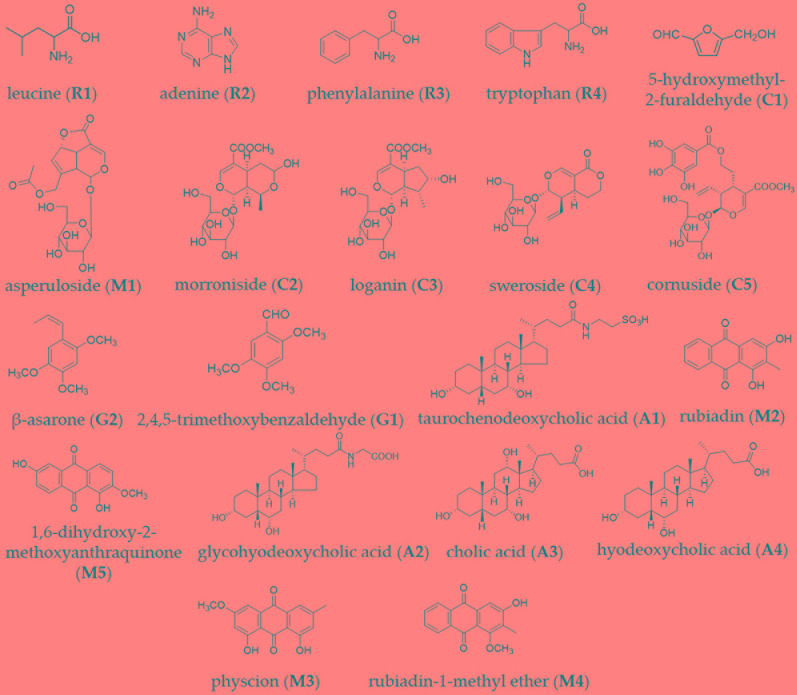
Chemical structure of the major identified components in BZD by UHPLC-MS: leucine, adenine, phenylalanine, tryptophan, 5-hydroxymethyl-2-furaldehyde, asperuloside, morroniside, loganin, sweroside, cornuside, β-asarone, 2,4,5-trimethoxybenzaldehyde, taurochenodeoxycholic acid, rubiadin, 1,6-dihydroxy-2-methoxyanthraquinone, glycohyodeoxycholic acid, cholic acid, hyodeoxycholic acid, physcion and rubiadin-1-methyl ether.